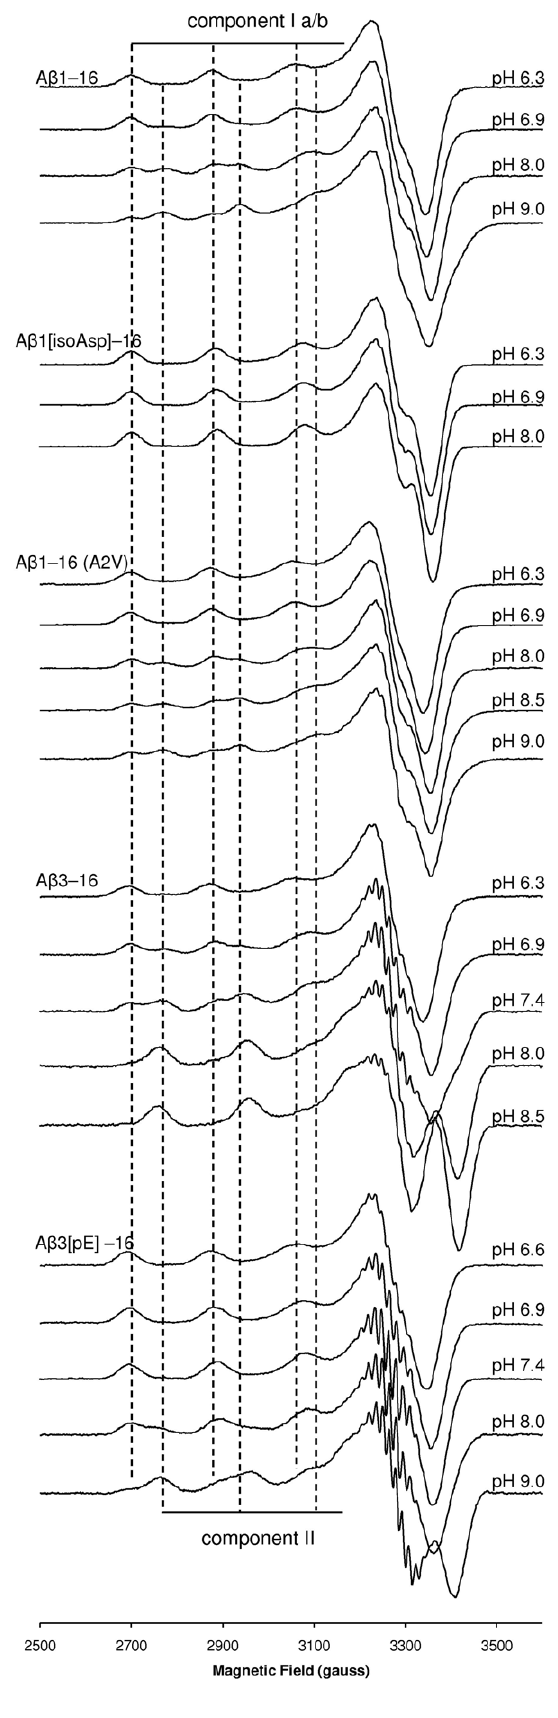
Figure 1. X-band (9.43 GHz) CW-EPR spectra of Cu 2 + /A b 1–16, Cu 2 + /A b 1–16(A2V), Cu 2 + /A b 1[isoAsp]–16, Cu 2 + /A b 3–16 and Cu 2 + /A b 3[pE]–16 (0.9 equiv 65 CuCl 2 ). For comparative purposes, dashed vertical lines identify the position of the resolved A || ( 65 Cu) resonances corresponding to component Ia/b and component II of Cu 2 + /A b 1–16. Spectra of Cu 2 + /A b 1[isoAsp]–16 and Cu 2 + /A b 1–16(A2V) correspond to the 13 C(1)-isoAsp1 and 13 C(1)-Val2 labelled analogues,